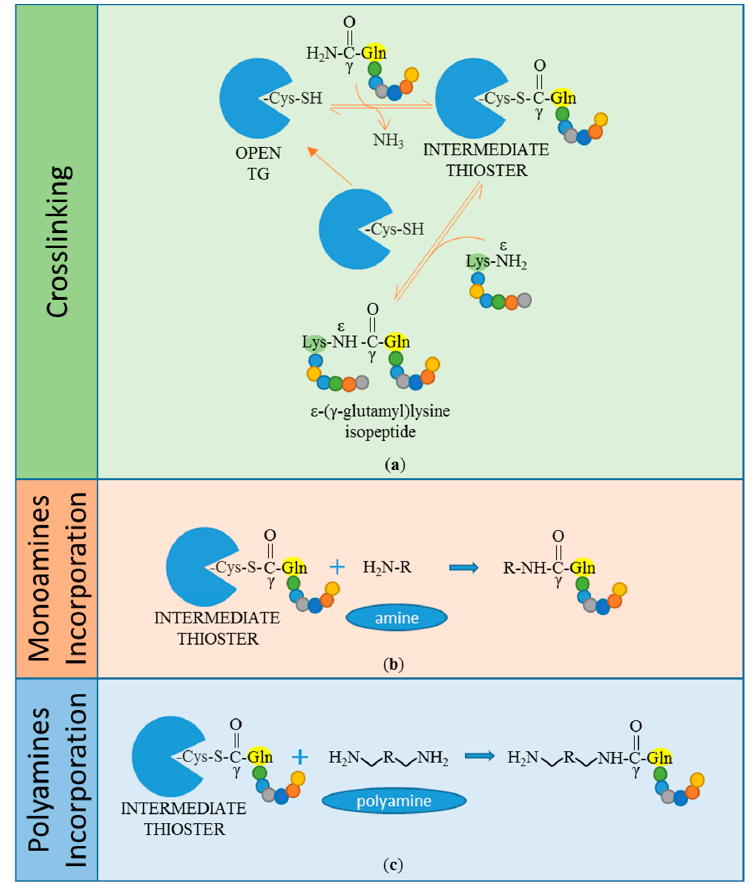
Figure 1. Transamidation reactions catalysed by transglutaminases (TGs). In response to triggering Ca 2+ concentration and in appropriate redox conditions, TG conformation is open and the catalytic cysteine (Cys) thiol (SH) group is prone to bind the γ -carboxamide group of a peptide-bound glutamine residue (Gln). Therefore, a thioester bond is created between the TG’s Cys and the Gln of a peptide target, with consequent ammonia release ( a ). TG catalyses the transfer of the acyl intermediate product to a nucleophilic substrate, like an ε -amino group of a peptide-bound lysine residue (Lys), leading to the formation of ε -( γ -glutamyl)lysine isopeptide bond, also called a crosslink ( a ). TG catalyses the incorporation of monoamines ( b ) or polyamines ( c ), acting as acyl-acceptors in a reaction similar to the crosslinking.